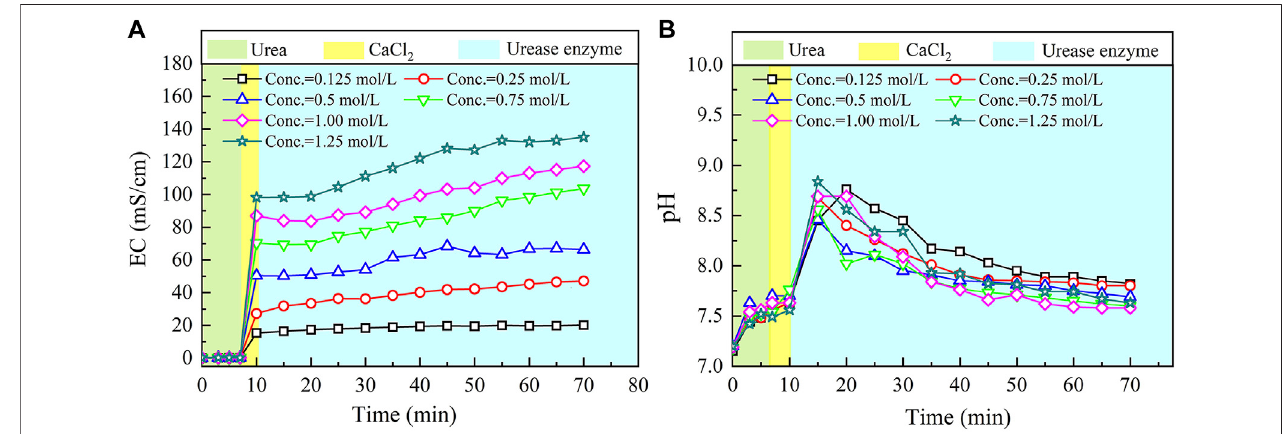
FIGURE 2 | Temporal relations of electric conductivity (EC) and pH in the ordinary enzyme-induced carbonate precipitation (EICP) process: (A) EC and (B) pH.